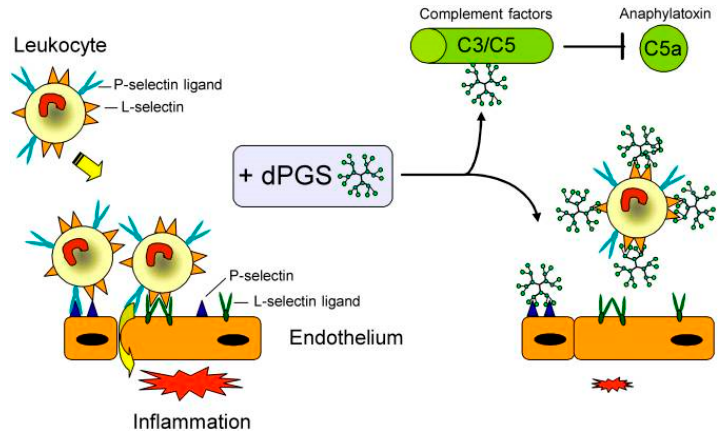
Figure 3. Pleiotropic anti-inflammatory effect of dPGS diminishes the inflammatory response and reduces leukocyte extravasation. Molecular targets of dPGS are the adhesion molecules L- and P-selectin. dPGS prevents leukocyte extravasation by shielding the selectins. Binding to complement factors C3 and C5 inhibits the formation of the proinflammatory anaphylatoxins. Reduction of the C5a level decreases vascular permeability and further leukocyte extravasation. By addressing these inflammatory targets simultaneously, dPGS promote the resolution of inflammation. Reprinted from [33].